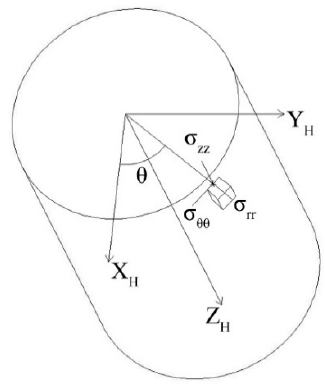
Figure 3. The stress components acting on the wellbore.